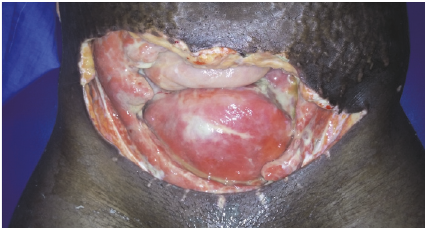
Figure2:Largeabdominaldefectexposingbowelanduterusasseen on day 10 after extensive debridement.